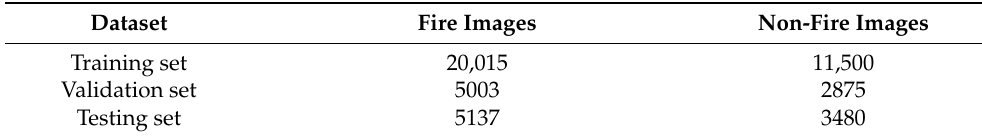
Table 4. Dataset subsets for